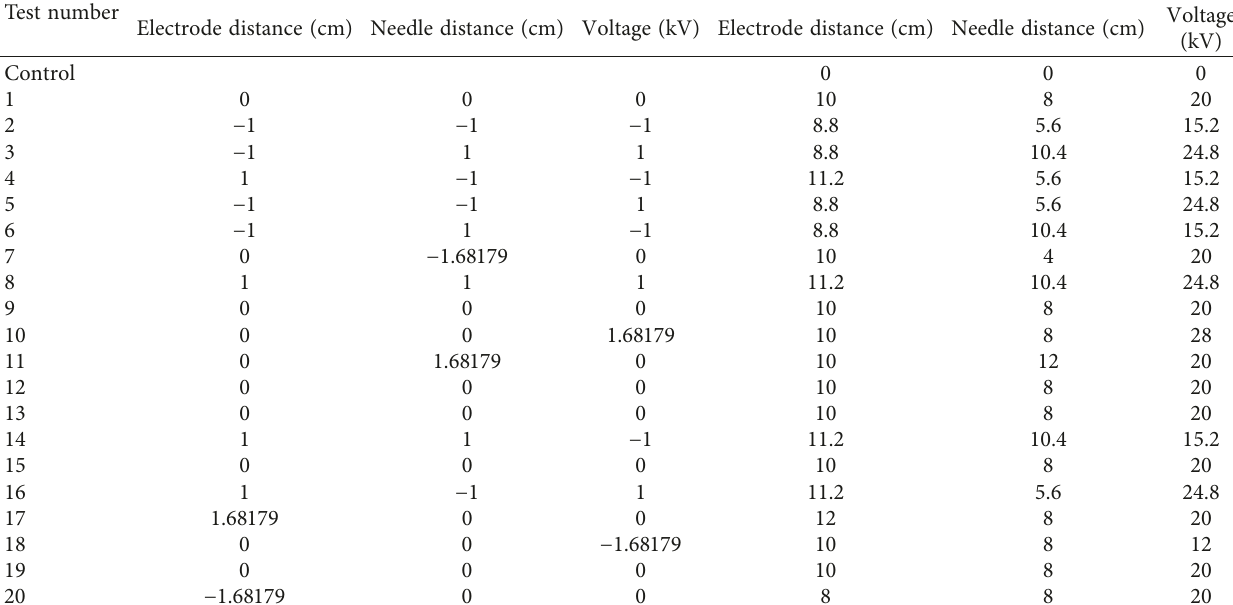
Table 2: The specific experiment design conditions using the response surface methodology.